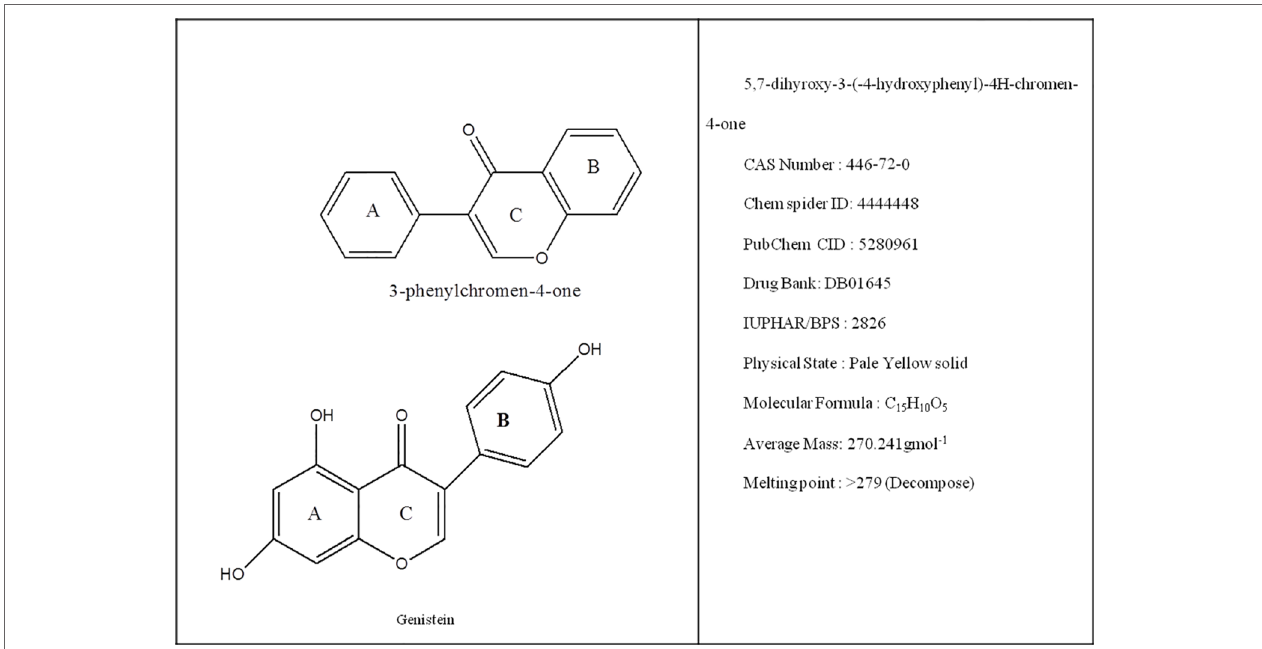
FIGURe 1 | Representation of basic nucleus of isoflavones along with chemical and physical properties of genistein.